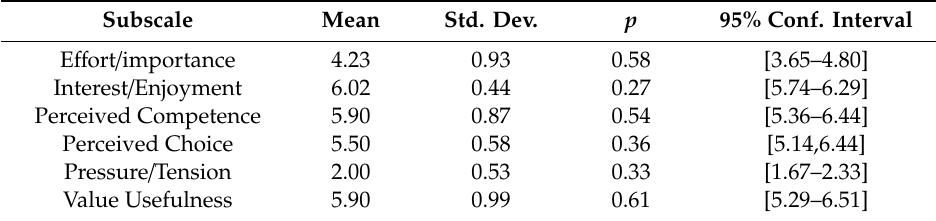
Table2. Scoresofparticipantspersubscaleoftheintrinsicmotivationinventory. p -valuesforcomparison to the middle point of the scale and 95% confidence intervals are